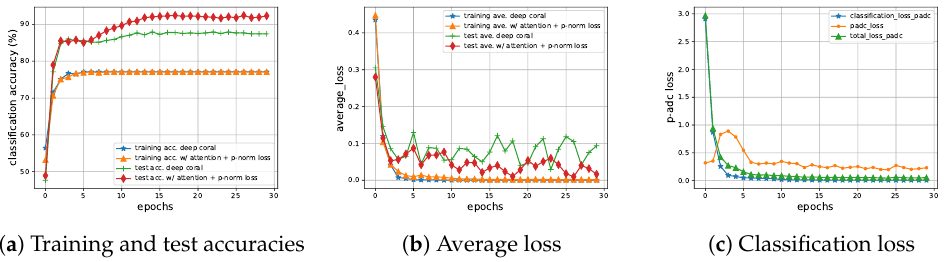
Figure 4. Comparative analysis of Deep CORAL and P-ADC ( 2 − 4 ) in shift D → W . ( a ) Training and test accuracies on Deep CORAL and P-ADC ( 2 − 4 ) . P-ADC ( 2 − 4 ) significantly outperforms Deep CORAL on the target domain under the same environmental setting. ( b ) Average loss value of Deep CORAL and P-ADC ( 2 − 4 ) in the training and test stage. ( c ) Classification loss value, p-norm loss value, and total loss value of P-ADC ( 2 − 4 ) ,